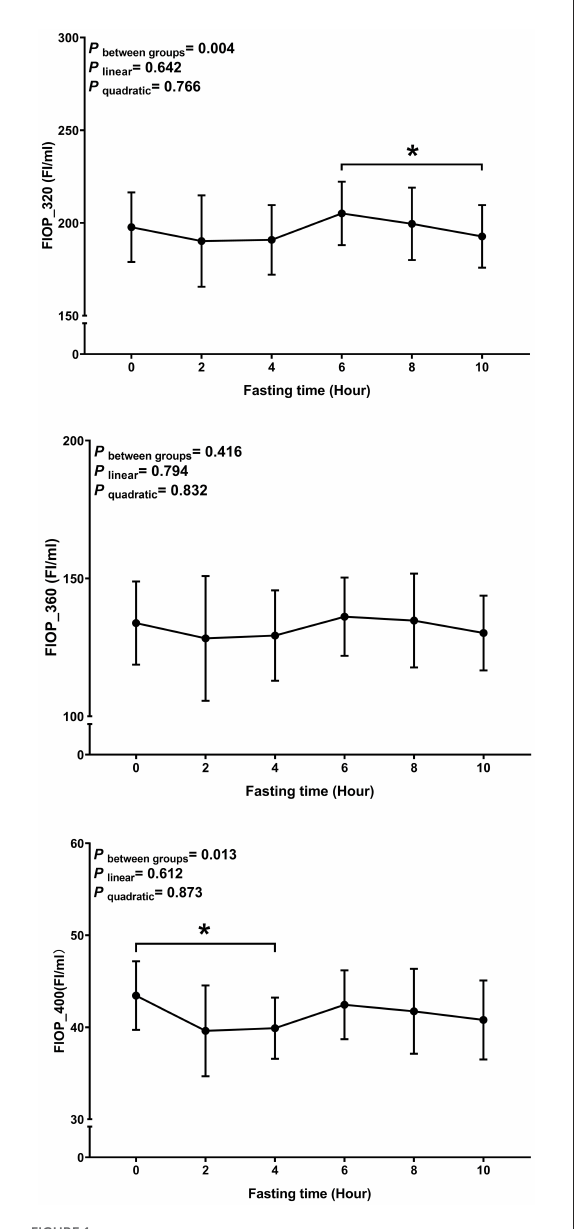
FIGURE1 Postprandial changes in plasma FlOPs with fasting time. Data are presented as the means, with error bars representing the 95% confidence intervals of the means. *Indicates a statistically significant difference of FlOPs at the 10th hour as compared with the other time points at alpha = 0.05; all statistically significant differences are